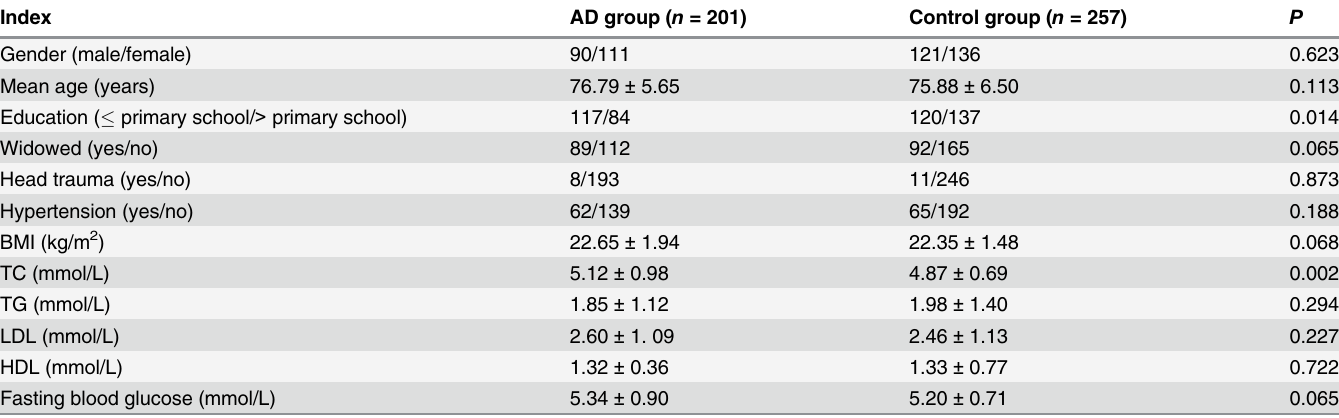
Table 2. Comparison of clinical characteristics between the AD and control